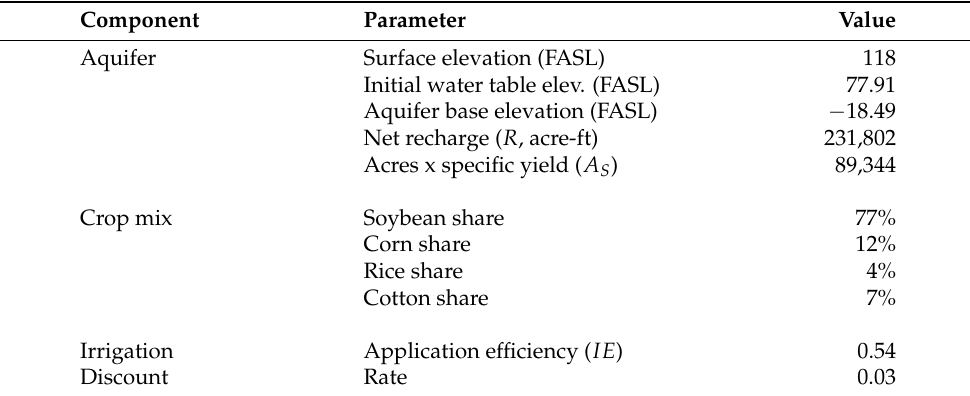
Table 1. Model parameters for Sunflower County,